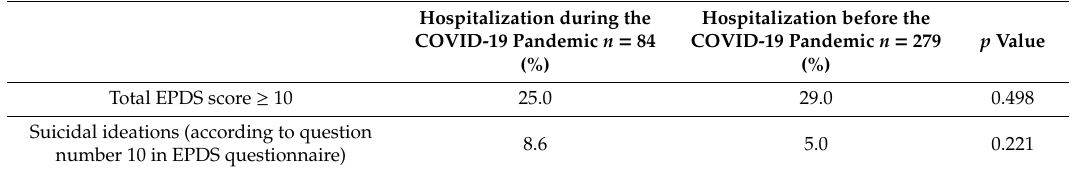
Table 3. Edinburgh Postnatal Depression Scale (EPDS) results among women hospitalized in the high-risk pregnancy units, during and before the COVID-19